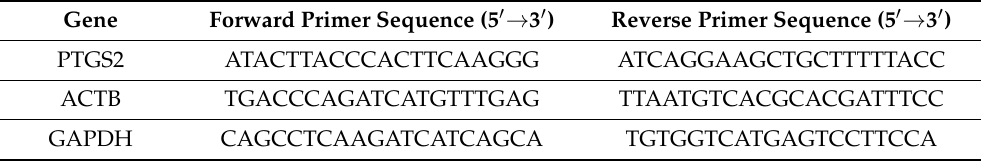
Table 3. List of primer sequences used for RT-qPCR analysis. Gene Forward Primer Sequence (5 (cid:48) → 3 (cid:48) ) Reverse Primer Sequence (5 (cid:48) → 3 (cid:48) )